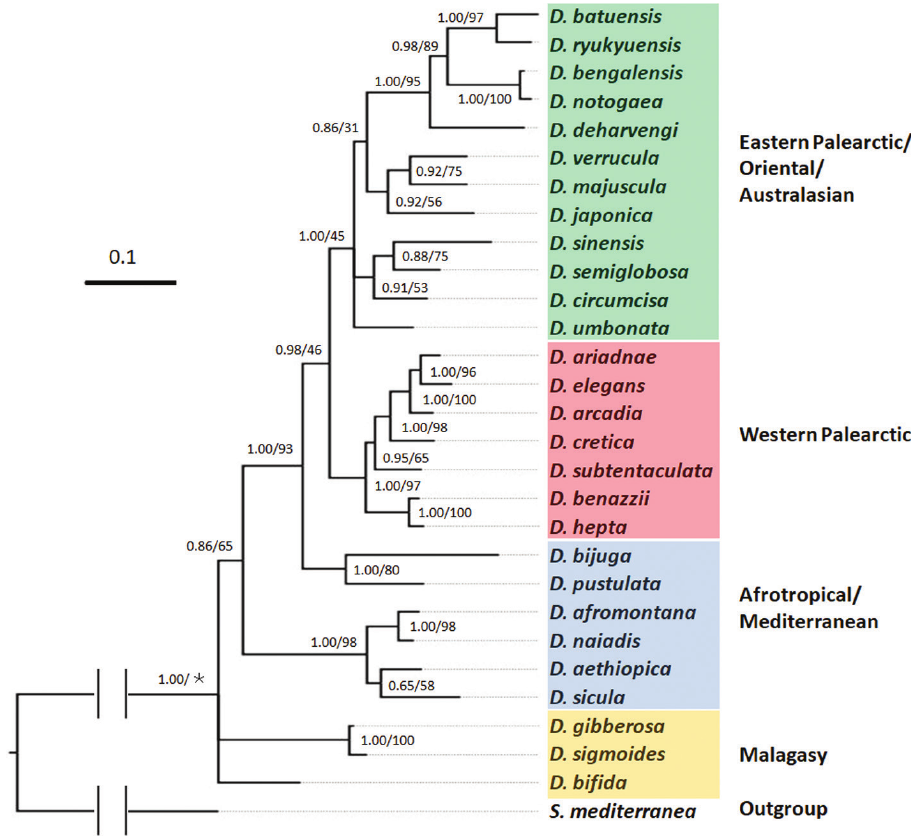
Figure 2. Phylogenetic tree obtained from Bayesian analysis of the concatenated dataset. Numbers at nodes indicate support values (pp/bs). ＊ : Bootstrap value not applicable to the node, because of different topologies of trees obtained by BI and ML methods. Scale bar: substitutions per